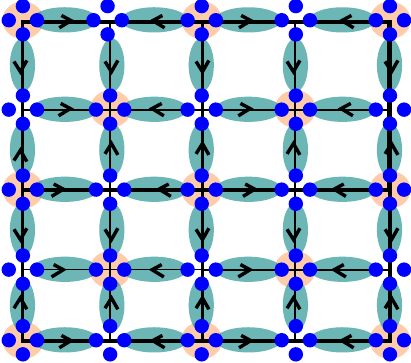
FIG. 10. A p 4 (actually p 4 m ) symmetric Majorana Hamiltonian. At each site, there are four Majorana operators (blue dots), which are hybridized along the teal bonds. An arrow c from Majorana c to Majorana c is a term − ð i= 2 Þ c in the i j i j Hamiltonian. The arrows are chosen to be a p 4 symmetric Kastelyn orientation, which is necessary for the ground state to be free of fermion parity π fluxes (see Refs. [111,128]). The C 4 rotation centers are highlighted in beige. The other sites are C 2 rotation centers.